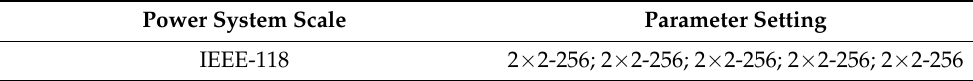
Table 4. Deep ConvLSTM model parameters for IEEE-118 bus power system.